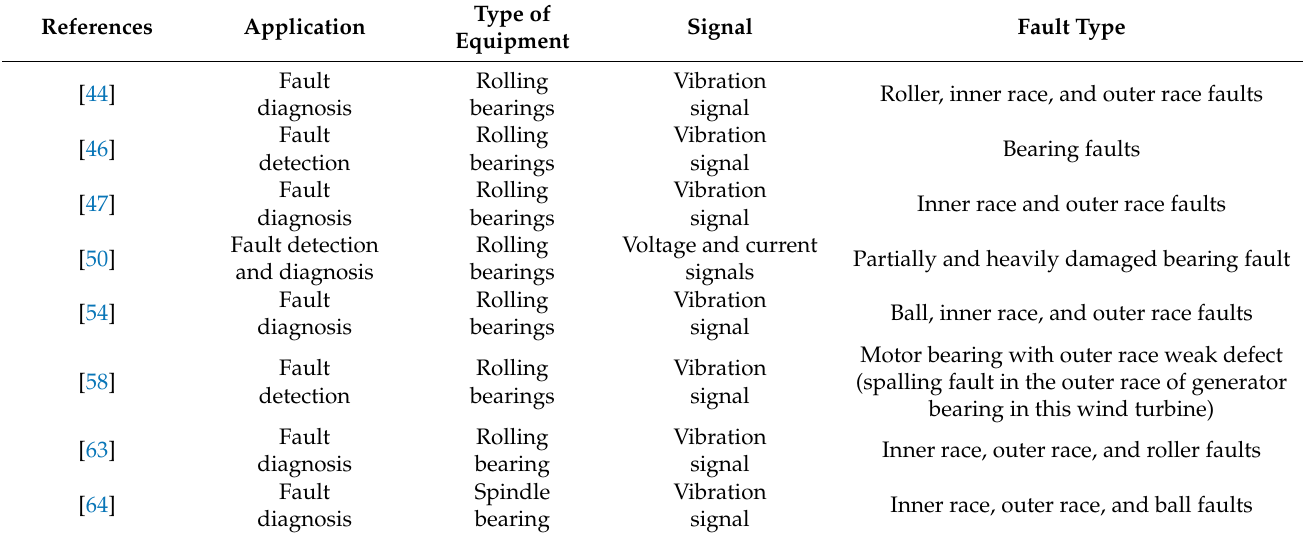
Table 6. Bearing condition monitoring using wavelet